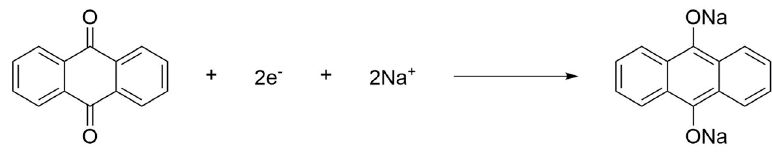
Figure 5. Reduction of 9,10-anthraquinone as model system for organic electrode materials.